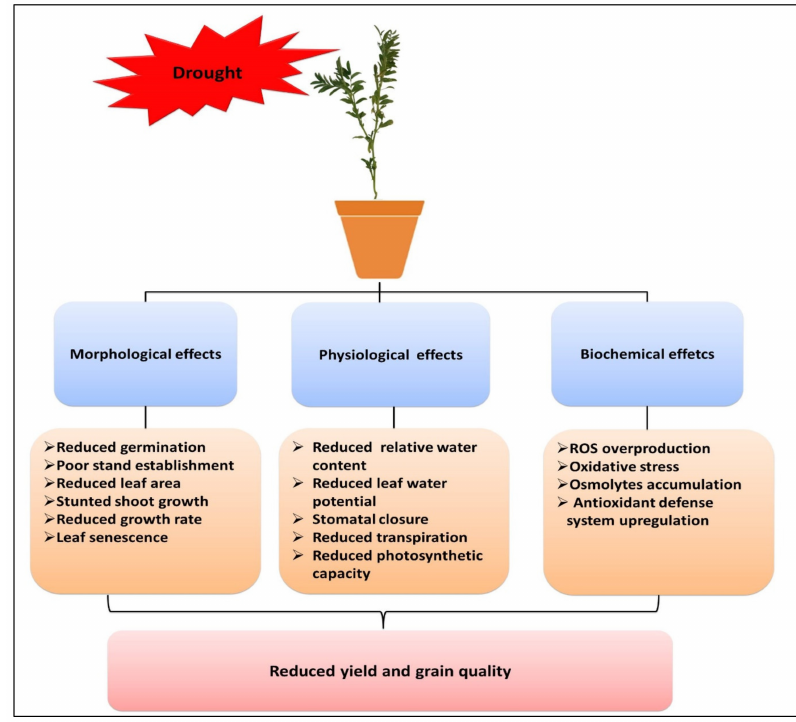
Figure 1. Effects of drought stress on